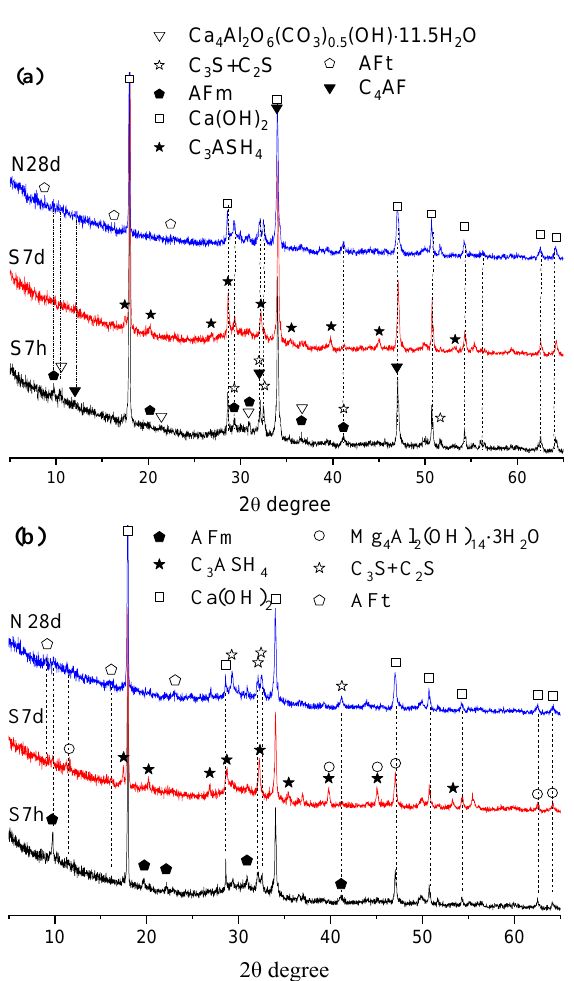
Figure 4. XRD of cement pastes under various curing conditions ( a ) Ref; ( b )